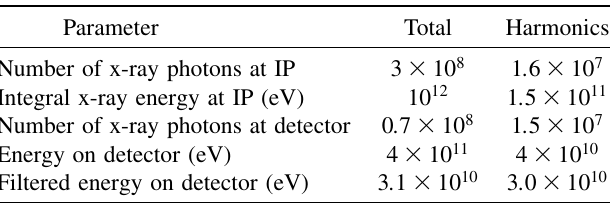
TABLE II. CAIN simulation results for the BNL-ATF’s ex- periment conditions.